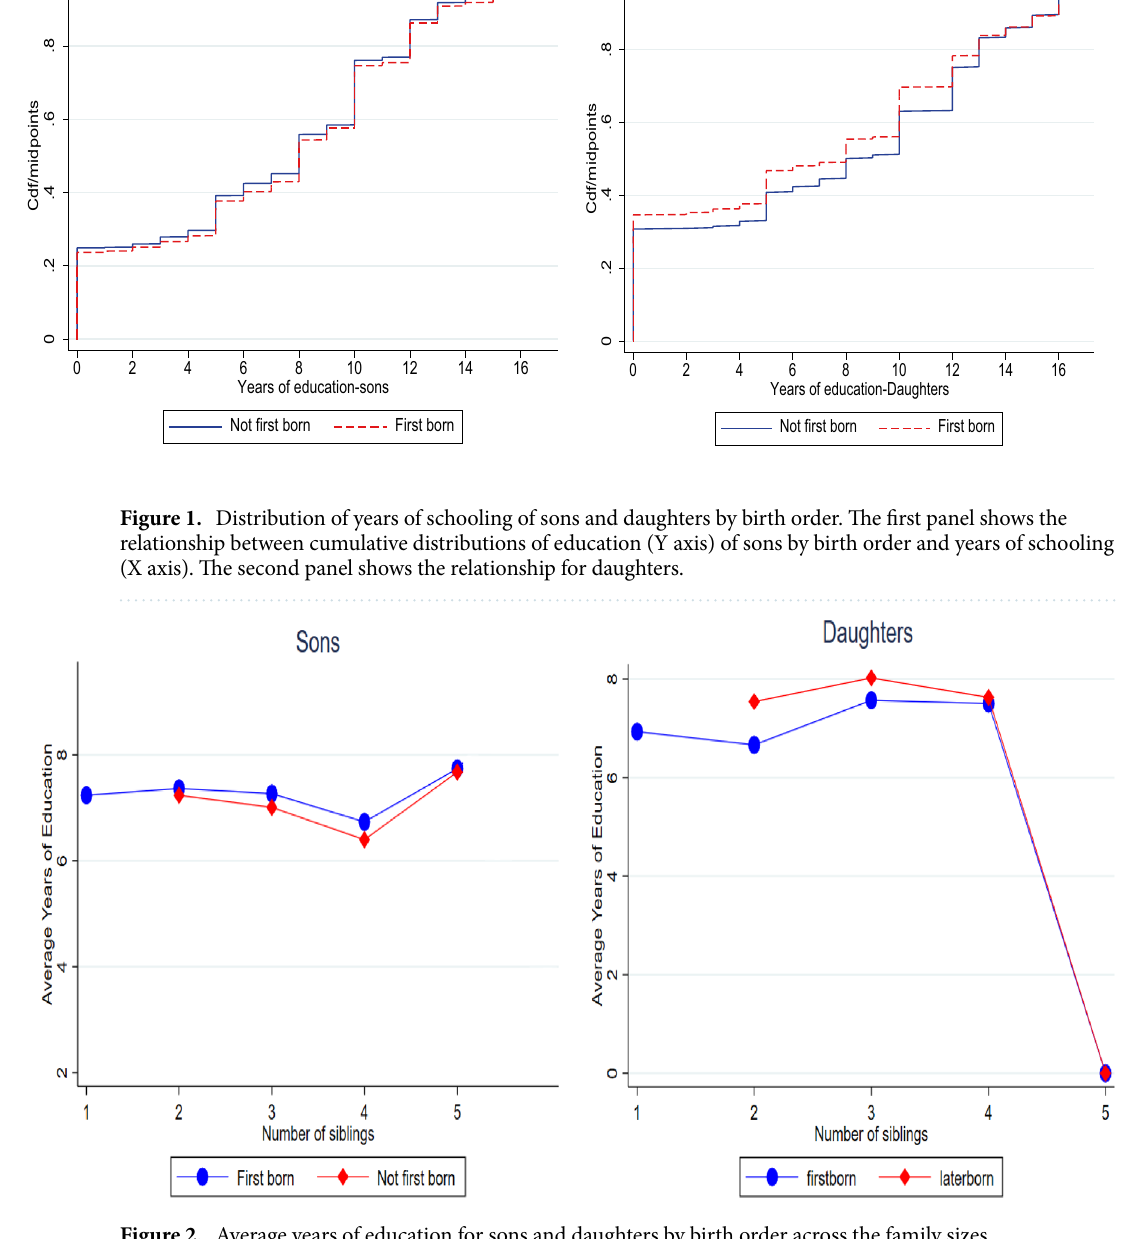
Figure 2. Average years of education for sons and daughters by birth order across the family